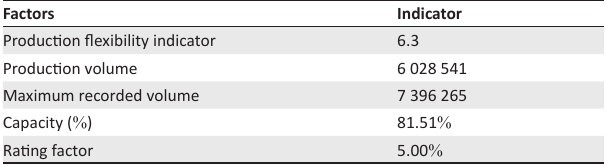
TABLE 17: Grading flexibility.